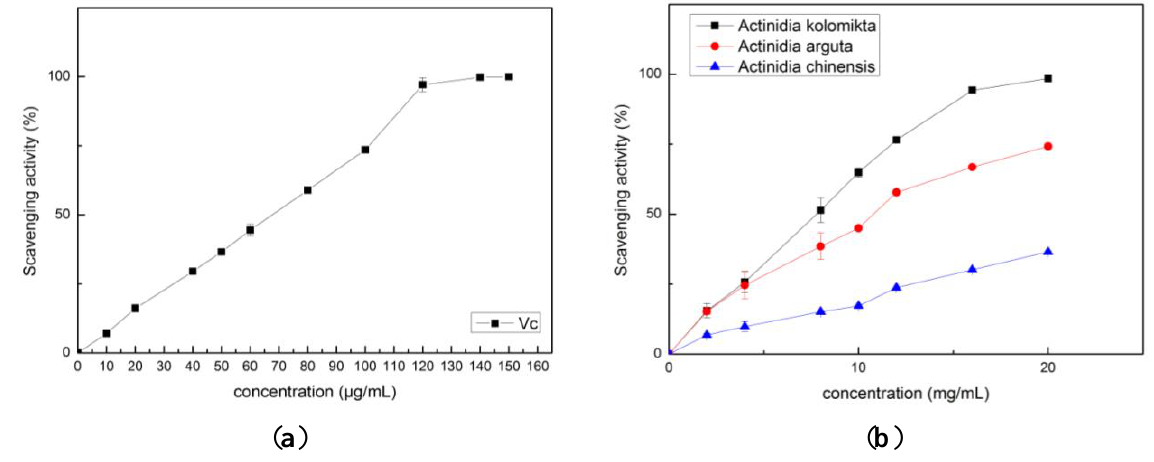
Figure 5. ( a ) The ABTS scavenging activity of vitamin C; ( b ) The ABTS scavenging activity of three Actinidia ethanol